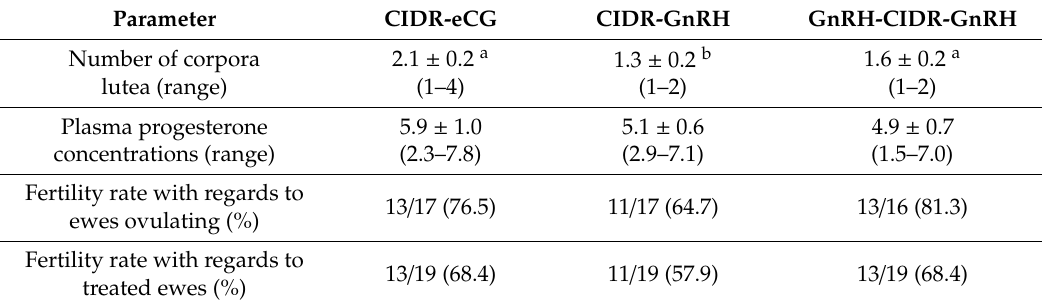
Table 2. Mean ( ± SEM) number of corpora lutea and plasma progesterone concentrations (ng / mL) and fertility rate in ewes treated with a single i.m. dose of 400 IU of eCG at CIDR removal